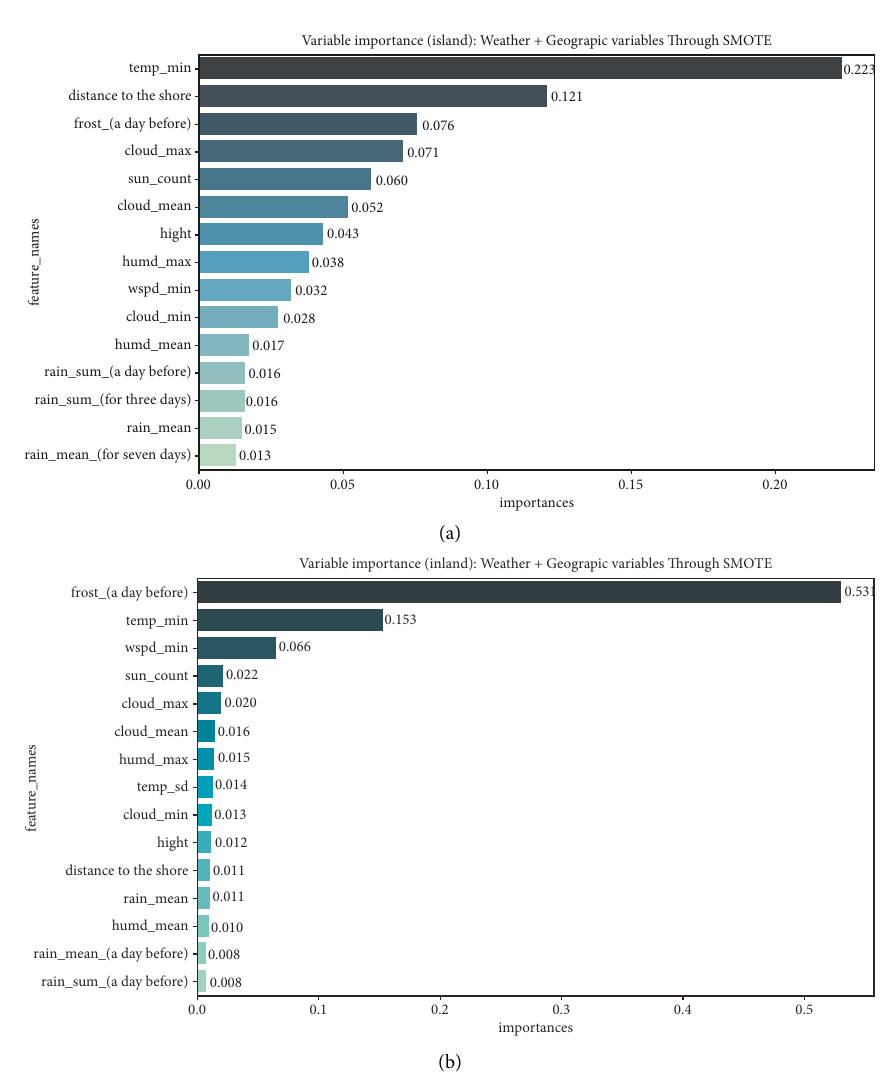
Figure 7: (a) Variable importance of XGBoost with all variables using SMOTE techniques in Group 1 and (b) variable importance of XGBoost with all variables using SMOTE techniques in Group 2. Table 9: Results of XGBoost by group with all variables using the SMOTE technique.